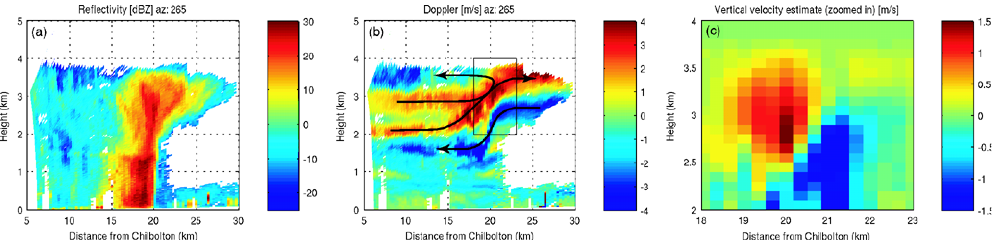
Fig. 9. RHI scan perpendicular to line of showers. Panel (a) shows radar reflectivity; (b) is Doppler velocity. Arrows indicating the air motion responsible for the convergence have been overlayed on panel (b) . Panel (c) shows a zoomed-in view of vertical velocity in the region of convergence (boxed area in panel b ), derived from integration of the 2-D continuity equation using the Doppler winds.